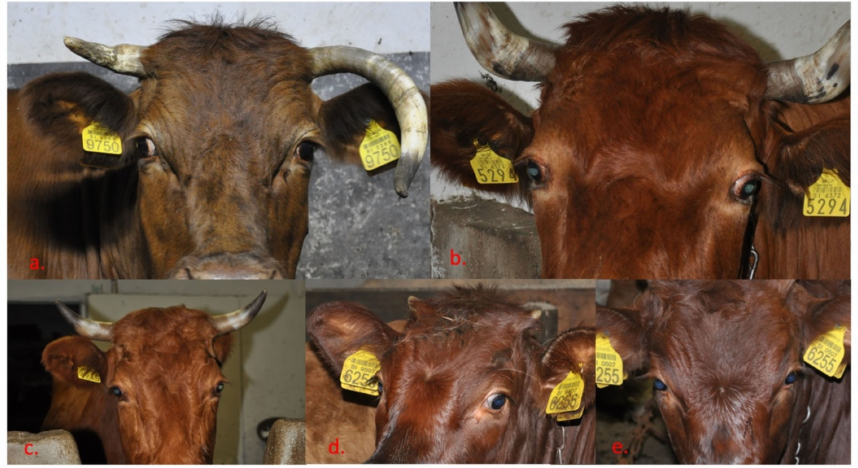
Figure 4. Eyes of the cows—carriers of the mutation: ( a ) Gavtraža with exophthalmos of the right eye, ( b ) Košuta with weak exophthalmos of the right eye and moderate exophthalmos of the left eye; ( c ) Breza with weak exophthalmos of the right eye, ( d ) a heifer with no signs of exophthalmos, ( e ) a heifer with no signs of exophthalmos (photographs: Simˇciˇc M.).